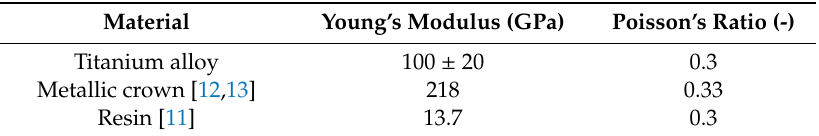
Table 1. Mechanical properties of materials.